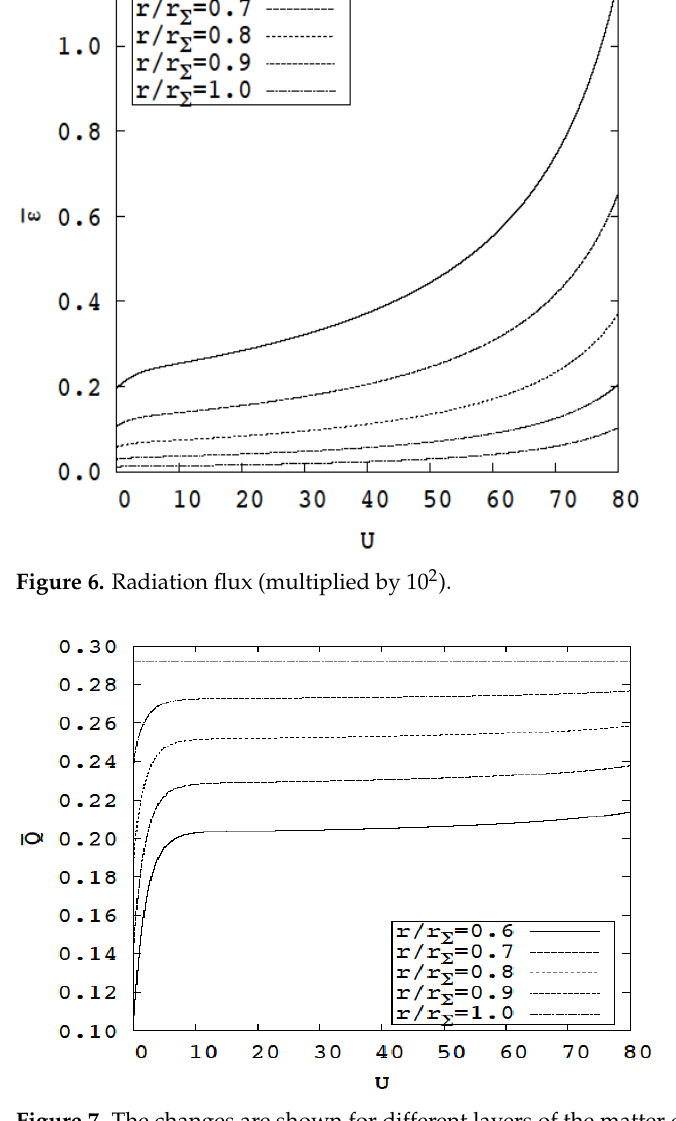
Figure 7. The changes are shown for different layers of the matter distribution .